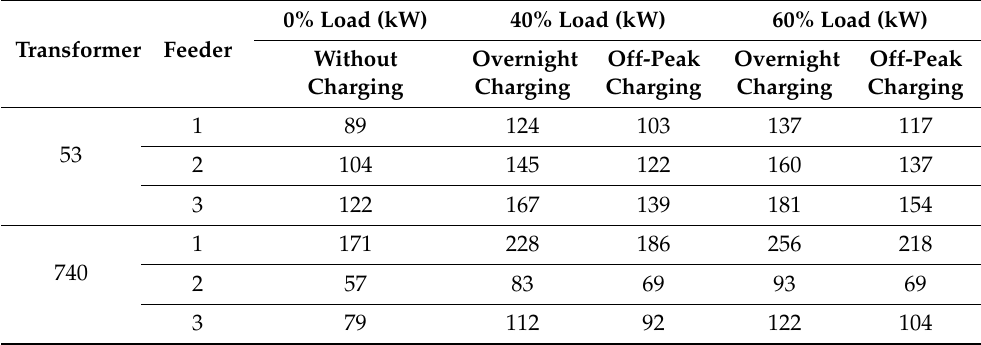
Table 7. Loading of the LV network in summer with 0%, 40%, and 60% EVC and different charg- ing schemes.